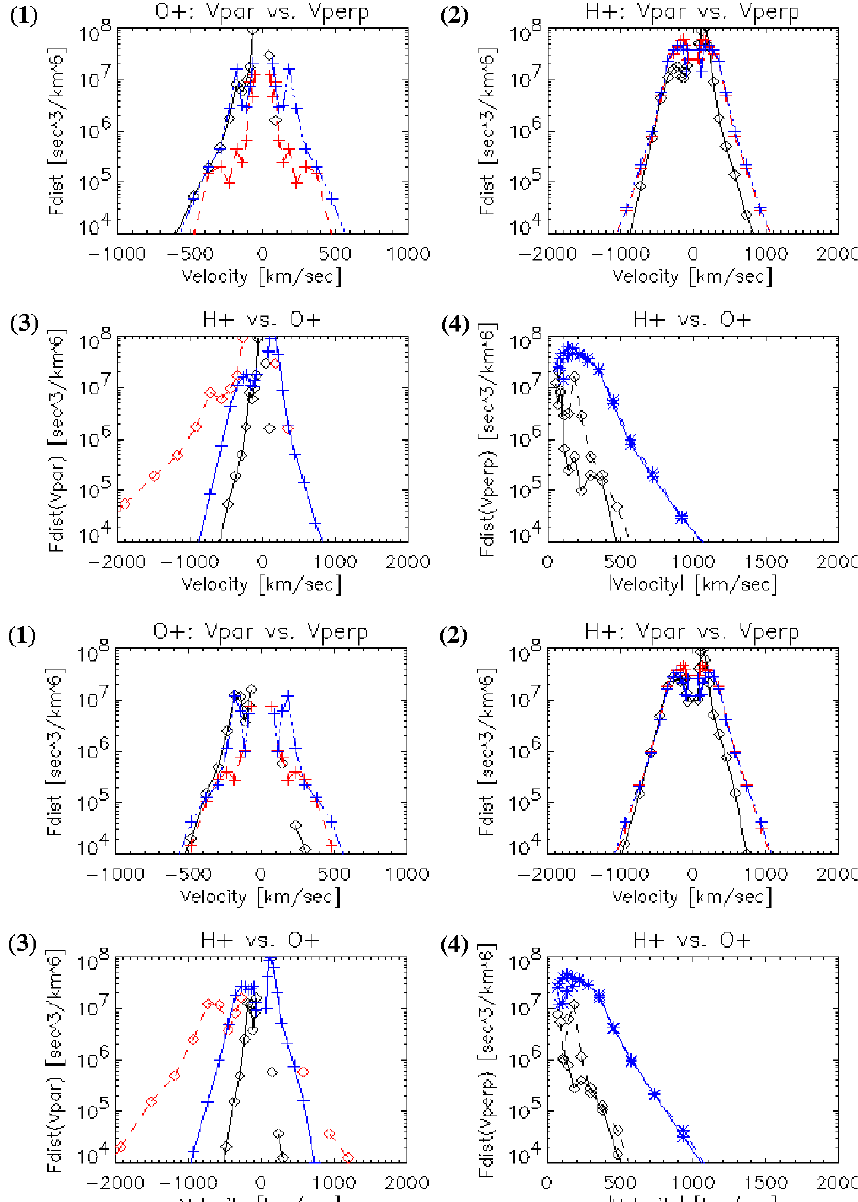
Fig. 4. The distribution functions ( f (V par ) and f (V perp ) ) of H + /O + ions observed by the Cluster S/C-3 at 09:49:26 UT (upper panel) and by the Cluster S/C-4 at 09:49:31 UT (lower panel). These observations are done by adjoining two spacecraft. The construction of the panels is explained in the